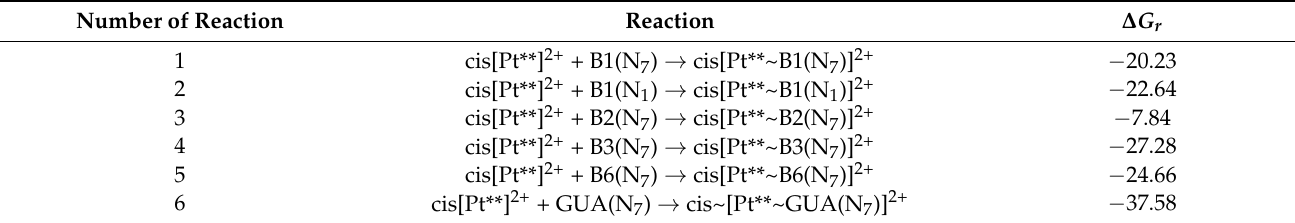
Table 2. The energetic characteristics of the cisPt-diaqua reactions with derivatives of vitamin B. All energies are given in kcal/mol. Symbol Pt** stands for Pt(NH 3 ) 2 (H 2 O) [33]. Number of